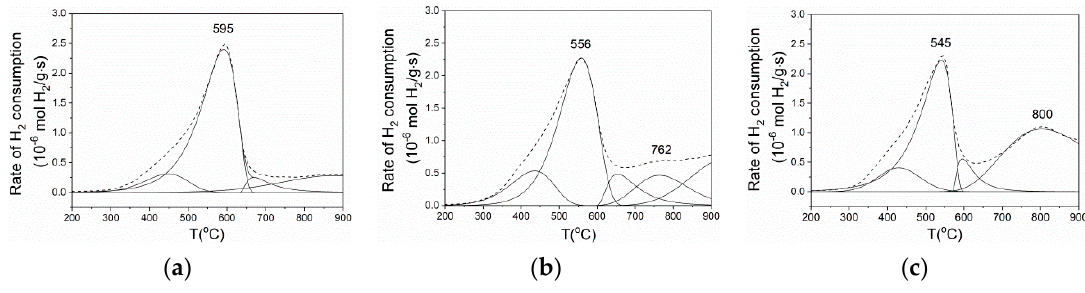
Figure 11. Temperature-programmed reduction (TPR) curves of Ce-Zr oxides: ( a ) Ce 0.3 Zr 0.7 ; ( b ) Ce 0.5 Zr 0.5 ; ( c ) Ce 0.7 Zr 0.3 . Table 4. H 2 consumption during TPR calculated by asymmetric Gauss decomposition method (AGDM). Sample